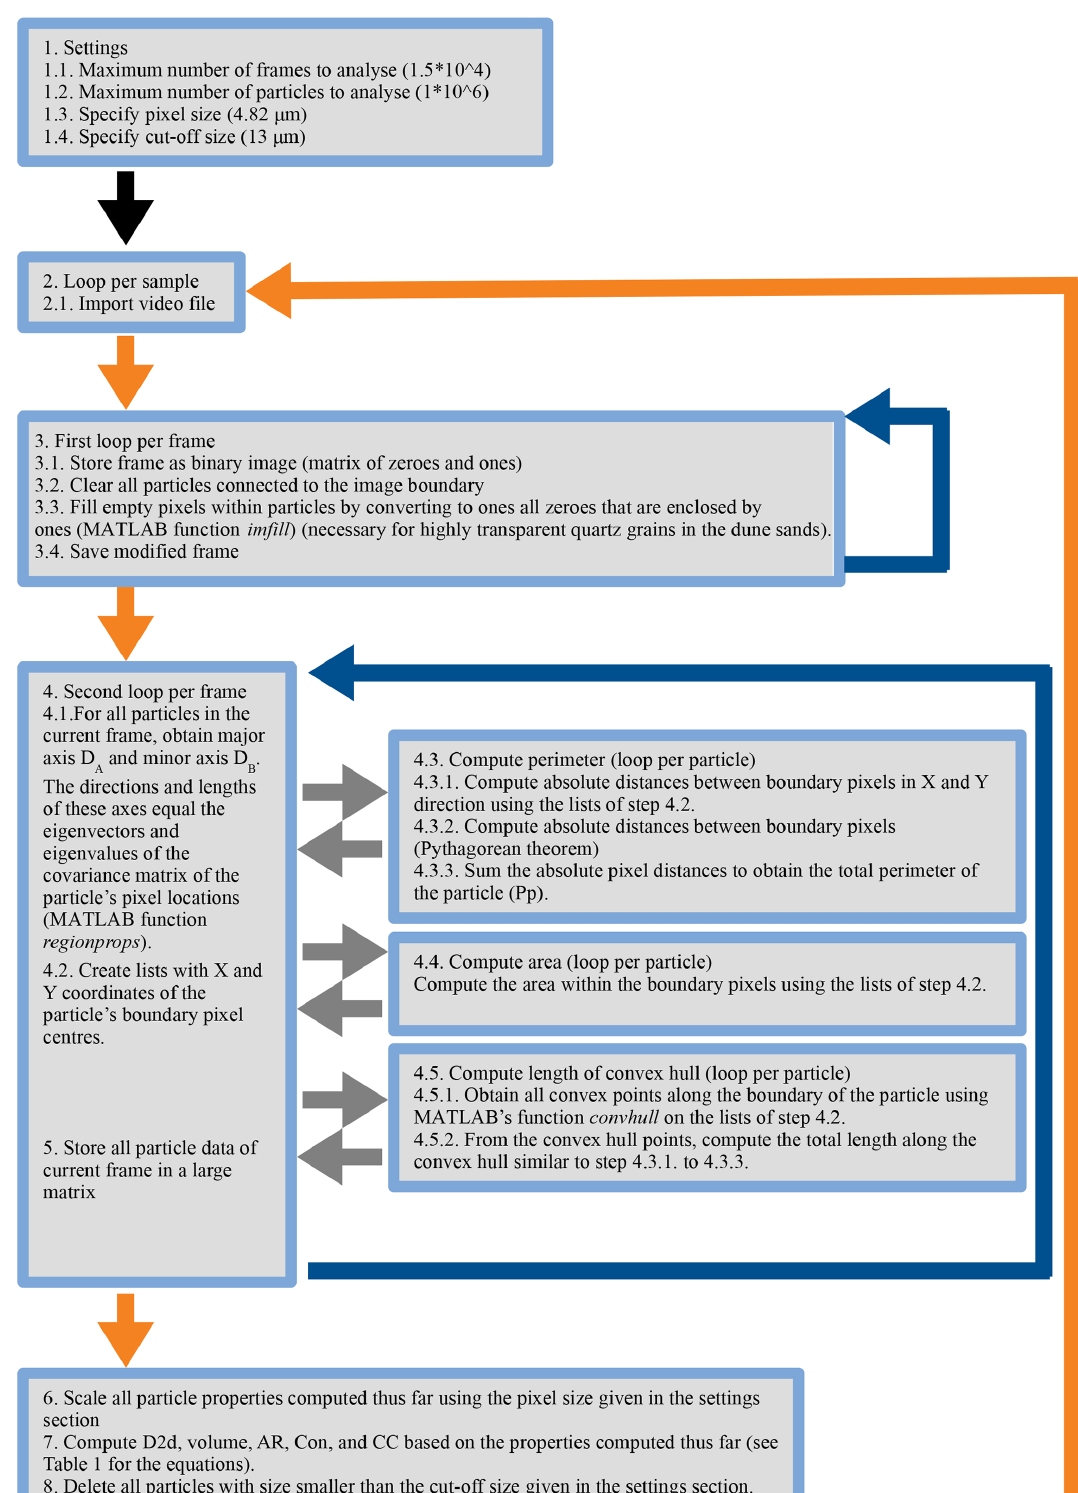
Figure A2. Flow diagram for the image processing